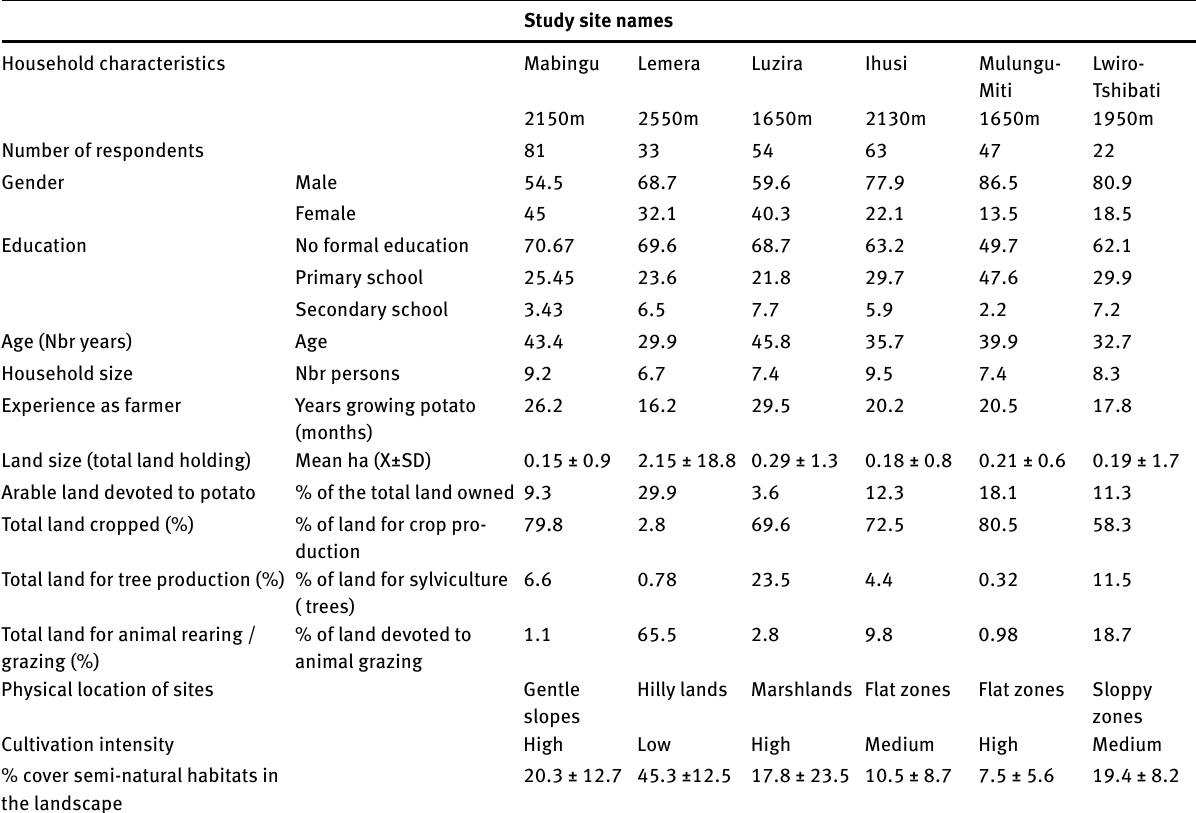
Table 2a: Household characteristics of interviewed farmers in the six sites of South-Kivu Province, eastern DRCongo (2016 surveys, N=300 respondents)